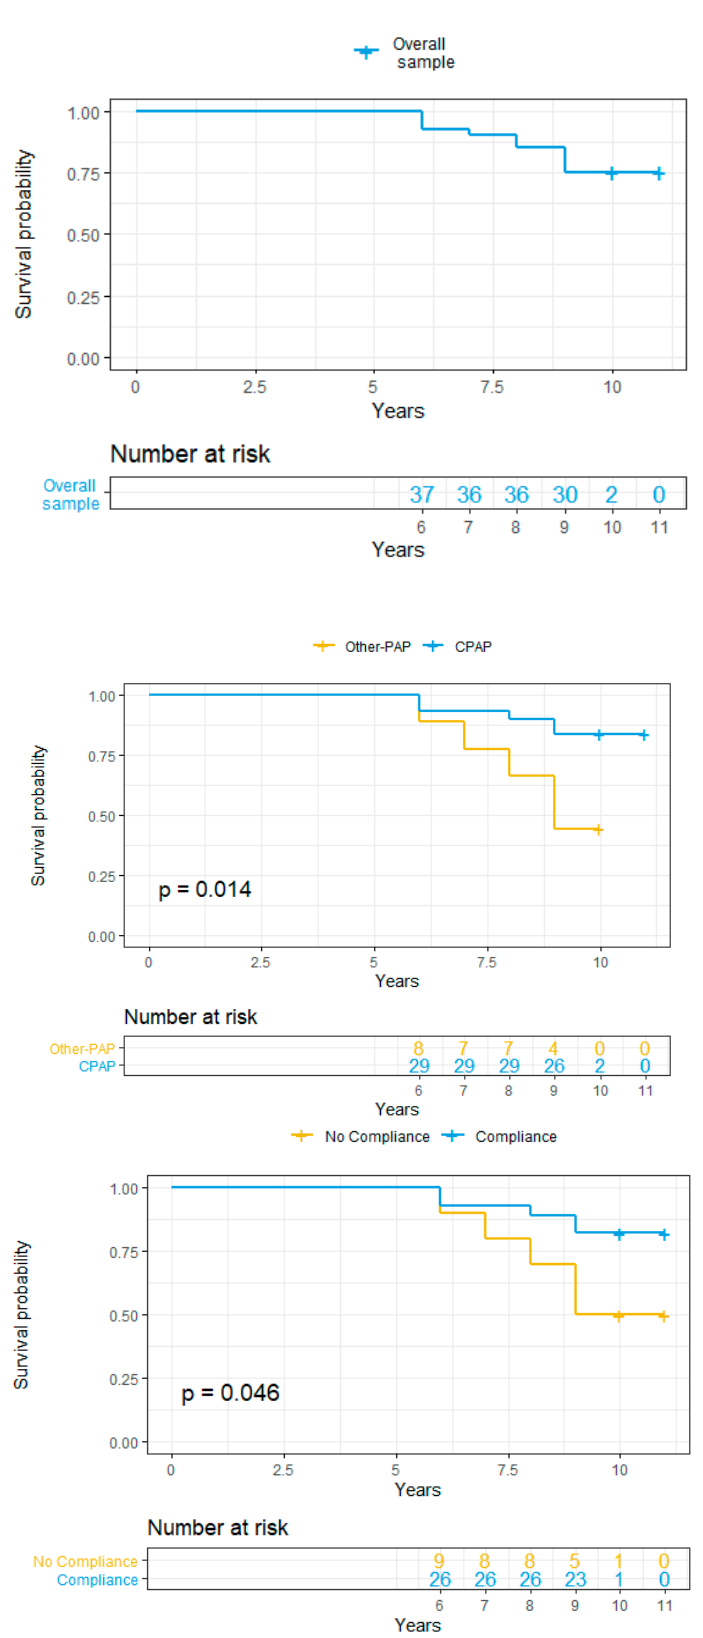
Figure 1. Kaplan – Meier Survival Curves overall and accordingly to PAP therapy and compliance. C- PAP = Continuous Positive Airway Pressure; PAP = Positive Airway